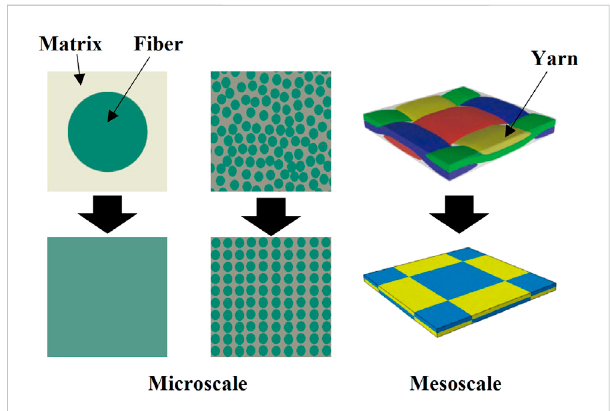
FIGURE 4 Homogenization of composites in microscale and